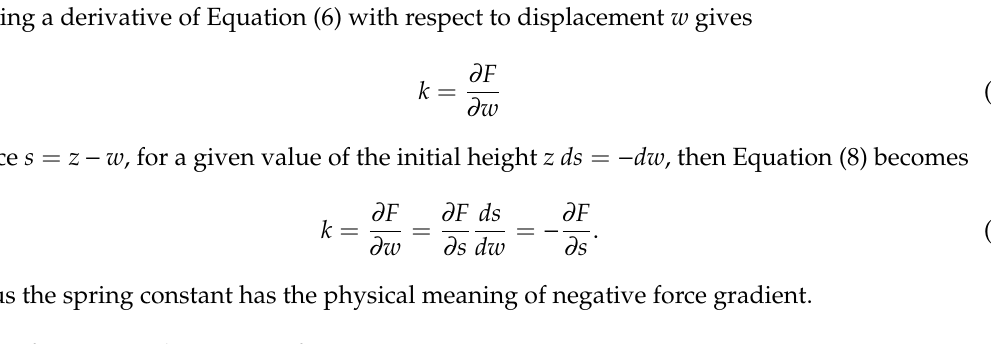
Figure 2. The linearized Lennard-Jones force is equivalent to a spring force kw plus a constant force F 0 .